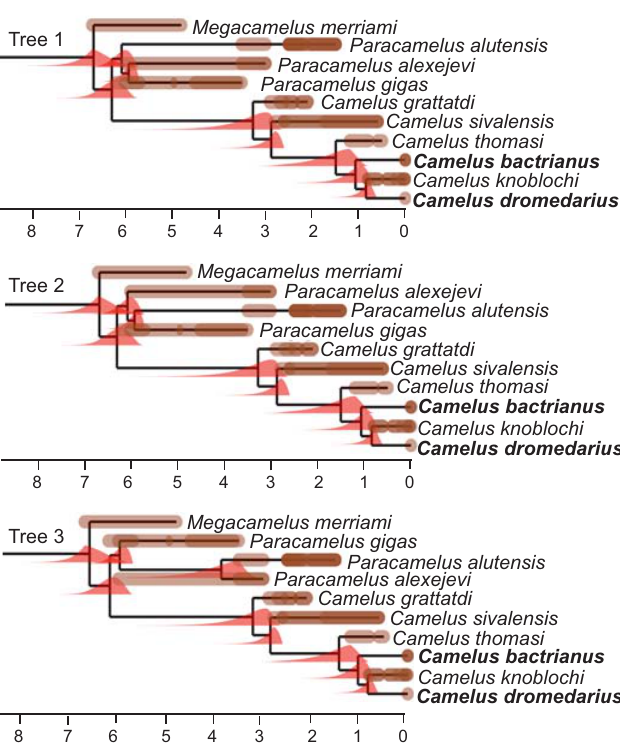
2. Time-calibrated equiparsimonious trees. At each node, the